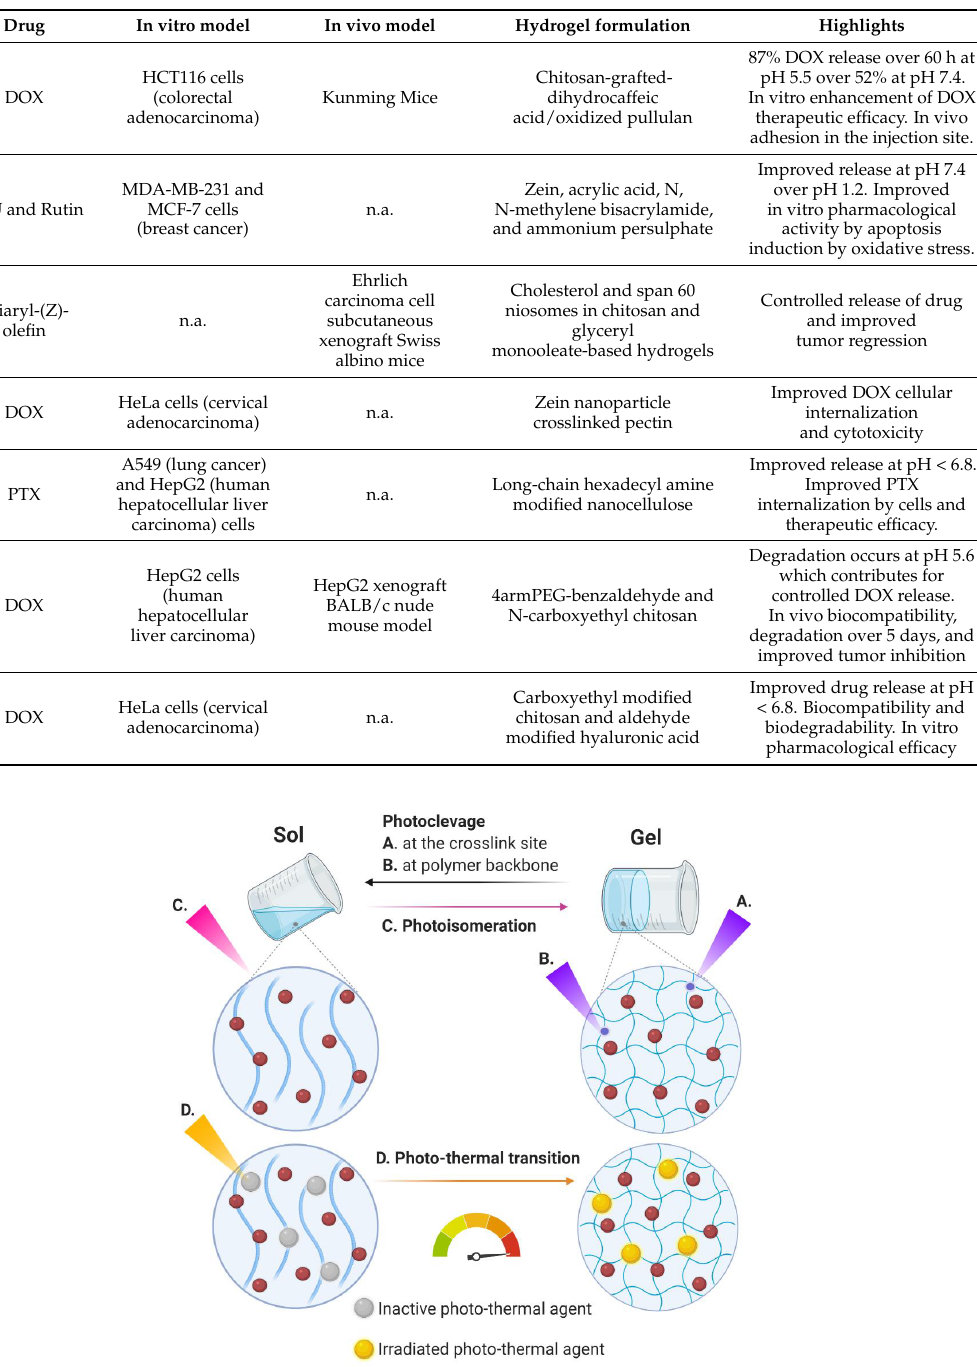
Figure 3. Schematic representation of photosensitive hydrogel. After exposure to light, the formu- lation suffers a chemical and/or physical alteration including ( A , B ) photoclevage, ( C ) photoiso- meration, and ( D ) photo-thermal transition. In the case of photo-thermal transition, the increase in the temperature promoted by the activation of photo-thermal agents could lead to a sol-to-gel or a gel-to-sol transition, accordingly the nature of the thermo-responsive polymer. The red circles represent the drugs loaded in the hydrogels. Created with BioRender.com (accessed on 15 January